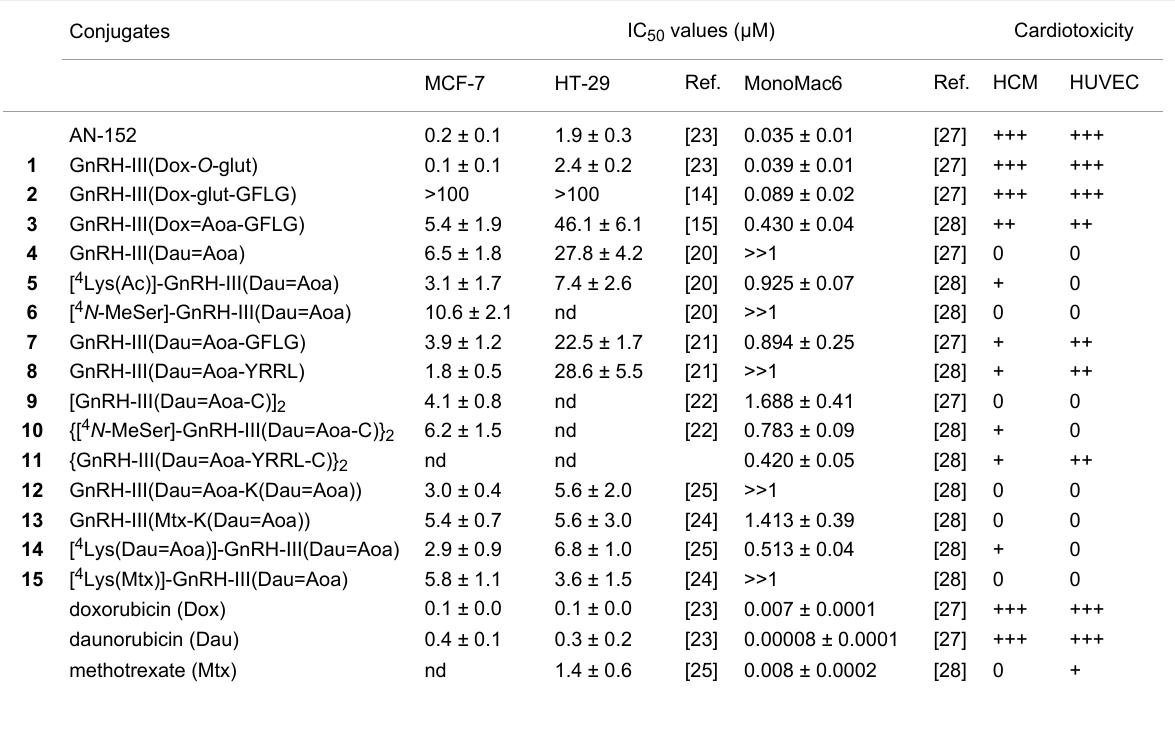
Table 1: Comparative study of cytotoxic effects and cardiotoxicity elicited by GnRH-based antitumor compounds ( 1 – 15 ) and reference substances (AN-152, Dox, Dau, Mtx). IC 50 values show antitumor cytotoxic characteristics of the conjugates in human breast cancer (MCF-7), human colorectal adenocarcinoma (HT-29) and human acute monocytic leukemia (MM6) derived cell lines as representative tumor cells. Human cardiac myocytes (HCM) and human umbilical vein endothelial cells (HUVEC) as the chief targets of cardiotoxic compounds were studied and compared with tumor